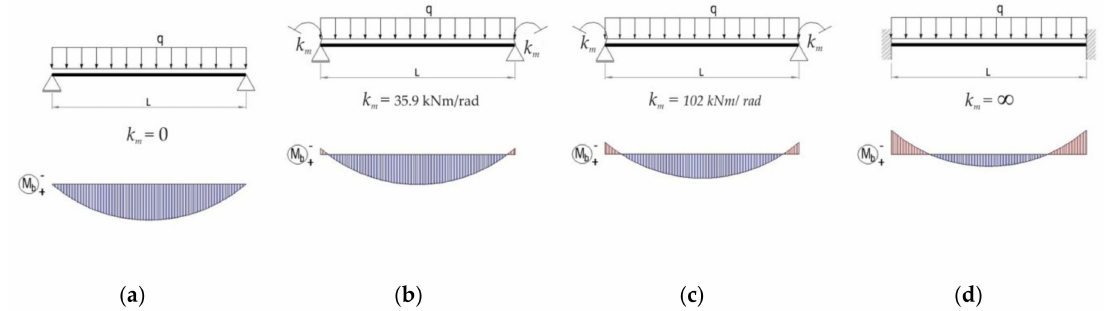
Figure 20. Bending moment diagram in case of di ff erent boundary conditions for beam B: ( a ) hinged beam ends, ( b ) semi-rigid connector with four tabs, ( c ) semi-rigid connector with five tabs, and ( d ) rigid connection (k m represents the rotational sti ff ness of both end